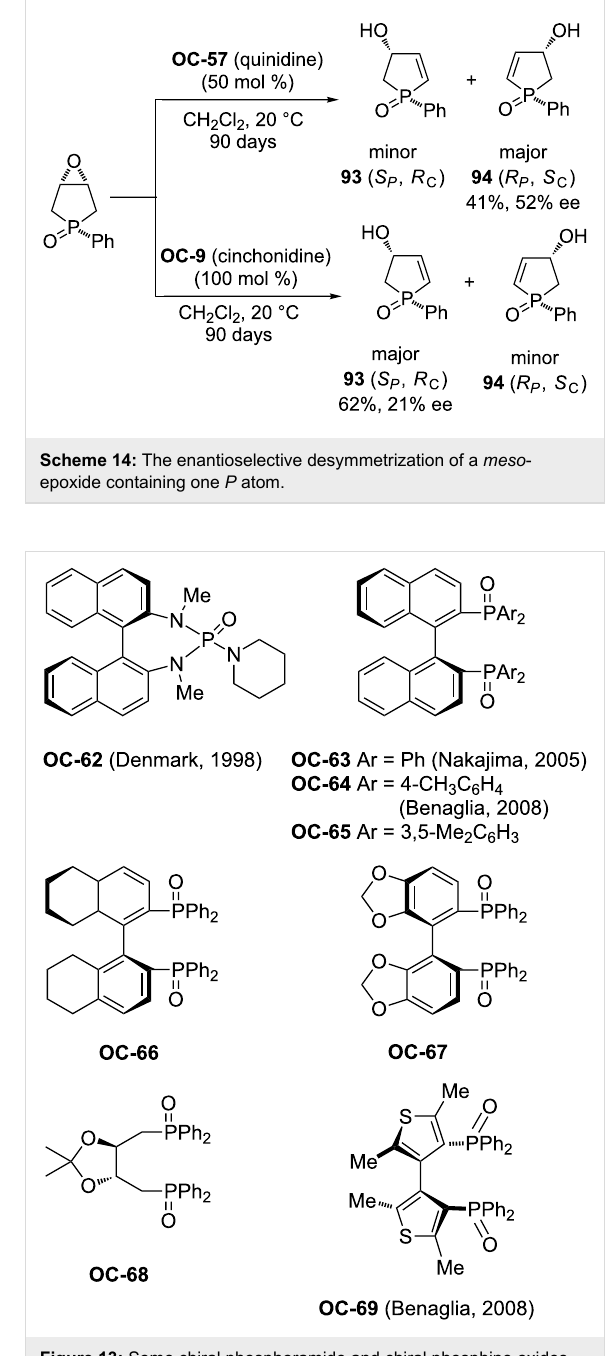
Figure 13: Some chiral phosphoramide and chiral phosphine